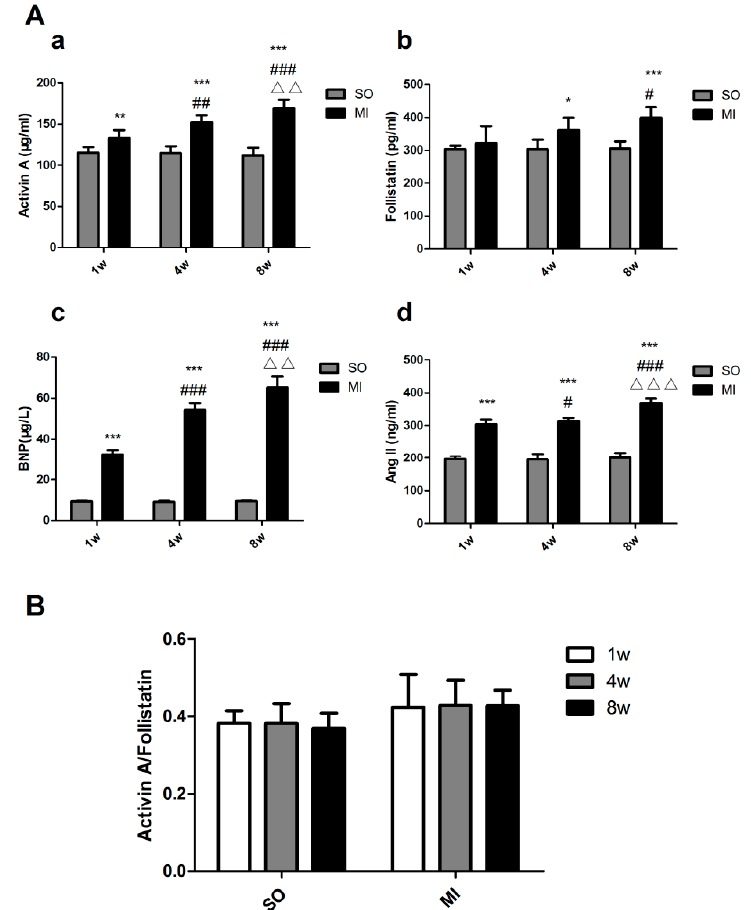
Figure 2. Expression levels of activin A–follistatin system, brain natriuretic peptide (BNP) and